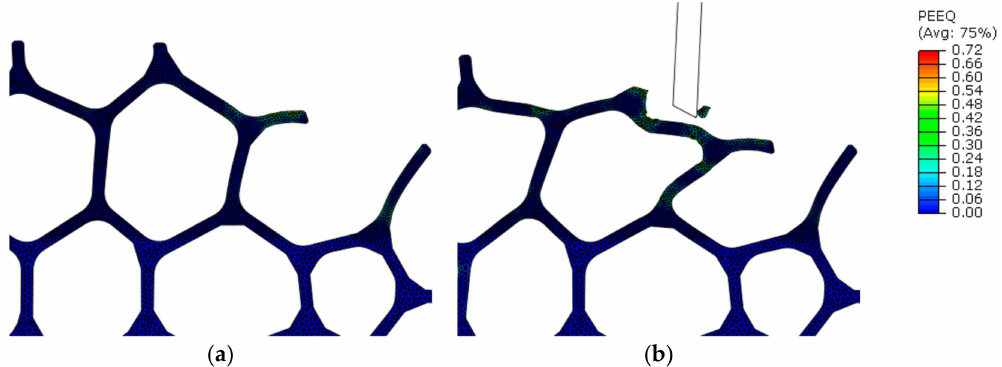
Figure 13. Plastic equivalent strain distribution in the region surrounding the tool path in down milling (Model A, v c = 400 m / min, f z = 0.03 mm): after 1st sweep ( a ) during 2nd sweep ( b ).